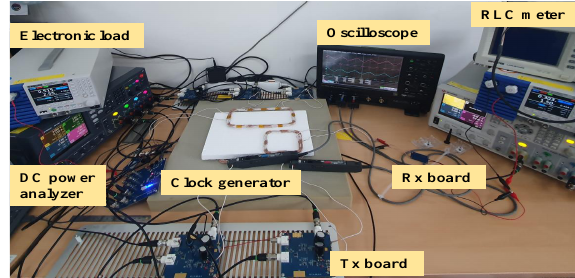
Figure 5. Experimental setup.